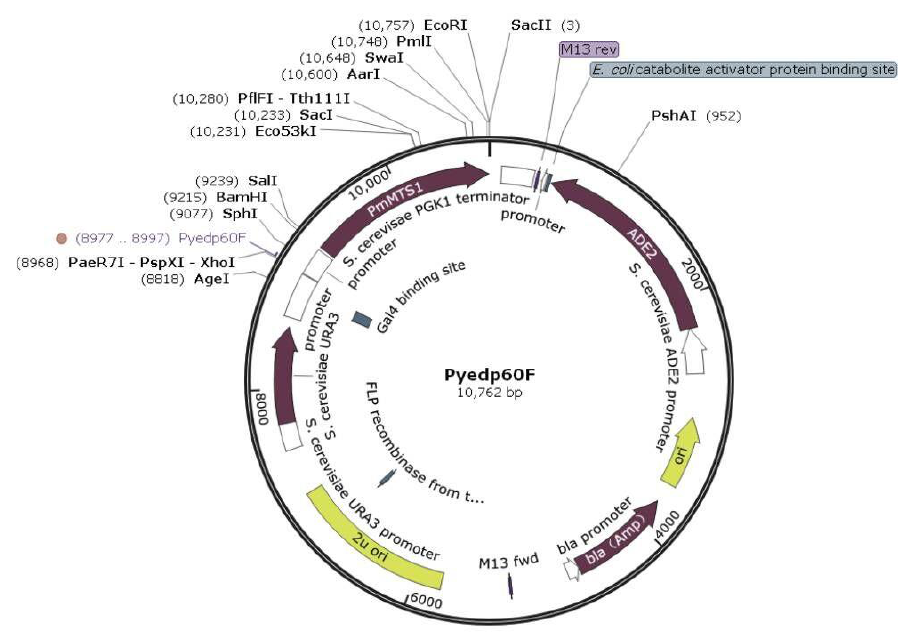
Figure A7. Map of the vector used in the yeast expression experiment created with SnapGene. Different protein showed with distinguished color.